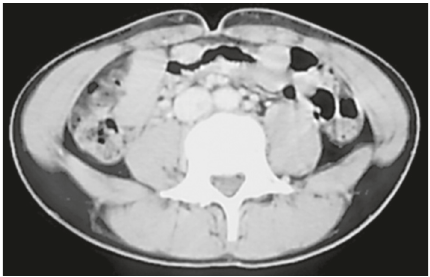
Figure 6: The tumor thrombus of IVC has completely vanished after irradiation and a 1 cycle of